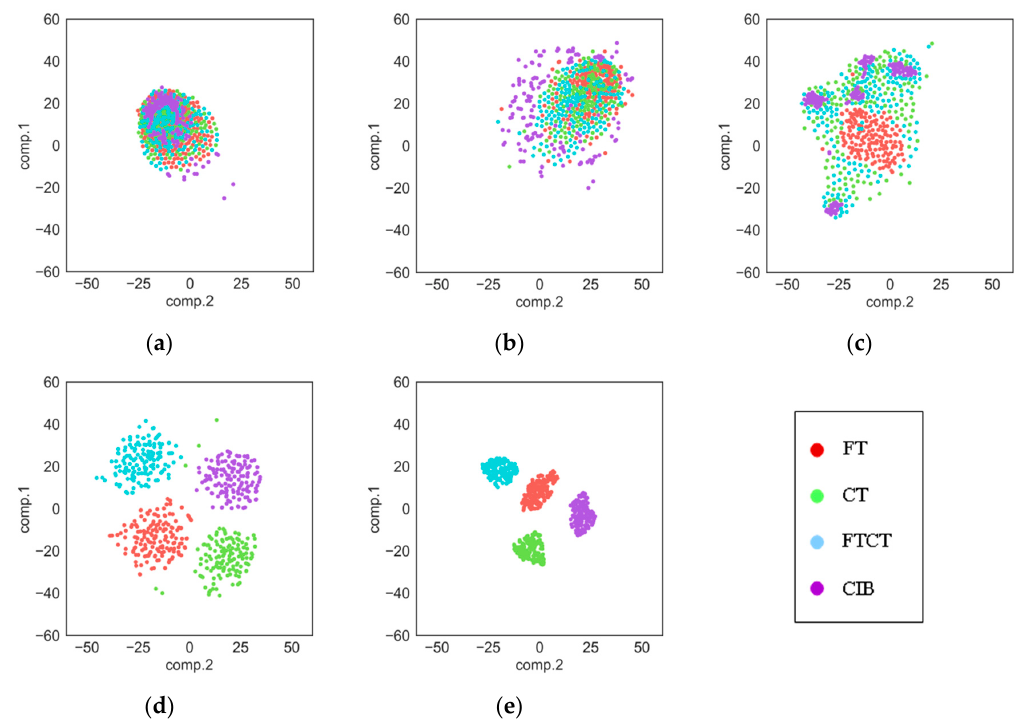
Figure 8. Feature visualization: ( a ) Raw data; ( b ) Local Convolutional layer; ( c ) Local ConvLSTM layer; ( d ) Holistic ConvLSTM layer; ( e ) Fully-connected (FC) layer.